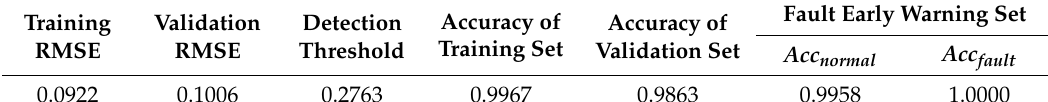
Table 3. Overall fault early warning performance of the proposed method